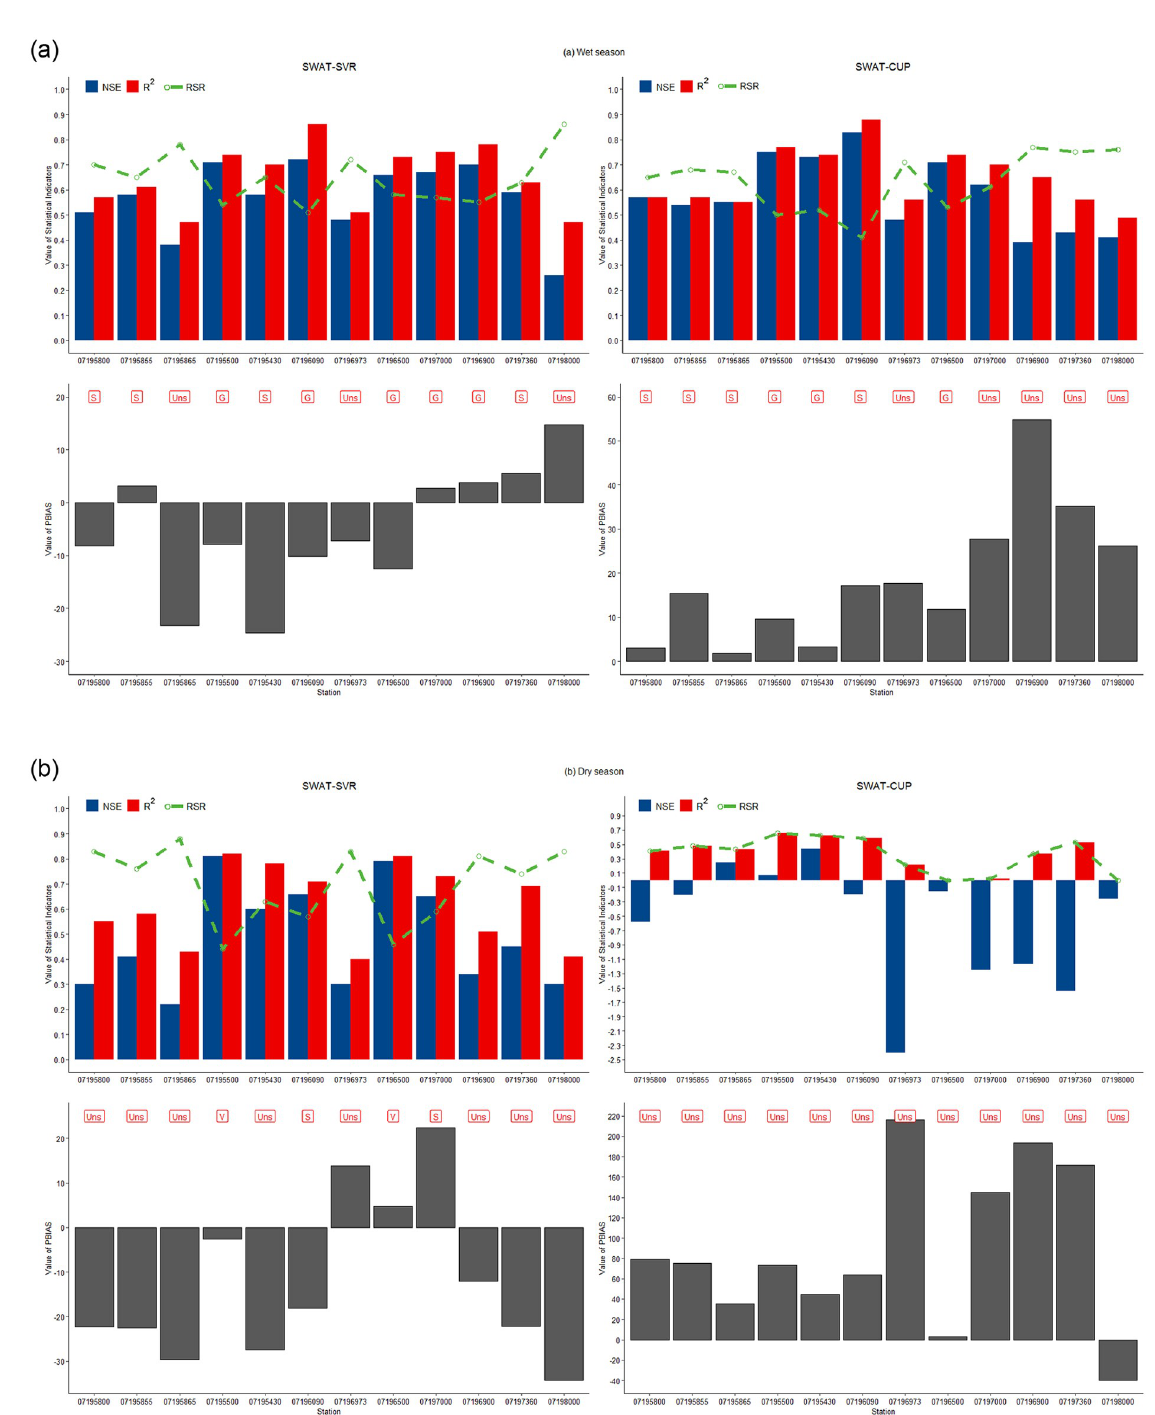
Fig 6. Comparison of performance ratings during the wet (a) and dry (b) seasons between SWAT-SVR and SWAT-CUP. (Performance Rating: V: Very good, G: Good, S: Satisfactory, Uns: Unsatisfactory).